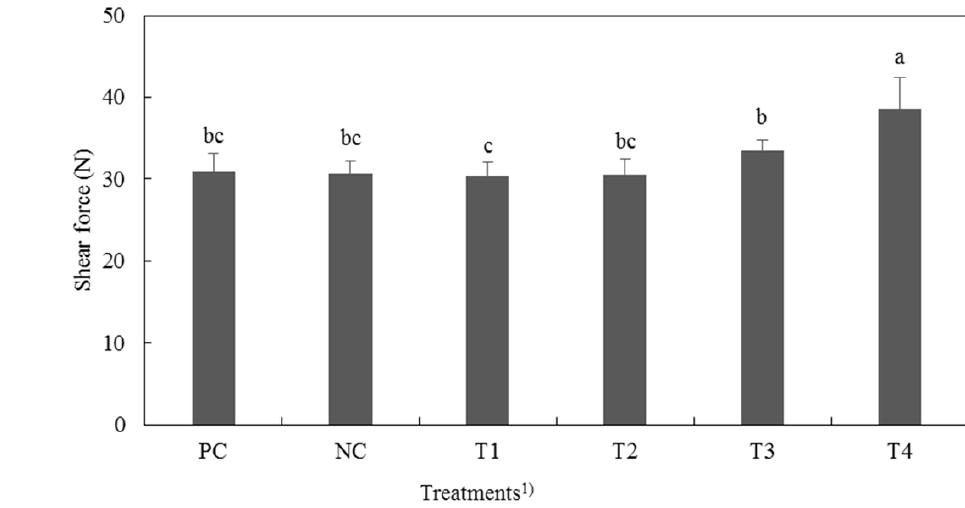
Figure 3. Warner-Bratzler Shear force contents of cured pork loin with natural nitrite source from fermented Swiss chard (FSC). 1) PC, positive control, 120 ppm nitrite; NC, negative control, nitrite-free; T1, FSC solution:water = 10:30; T2, FSC solution:water = 20:20; T3, FSC solution:water = 30:10; T4, FSC solution:water = 40:0. a-c Different letters on top of the column mean significant difference between treatments (p<0.05).